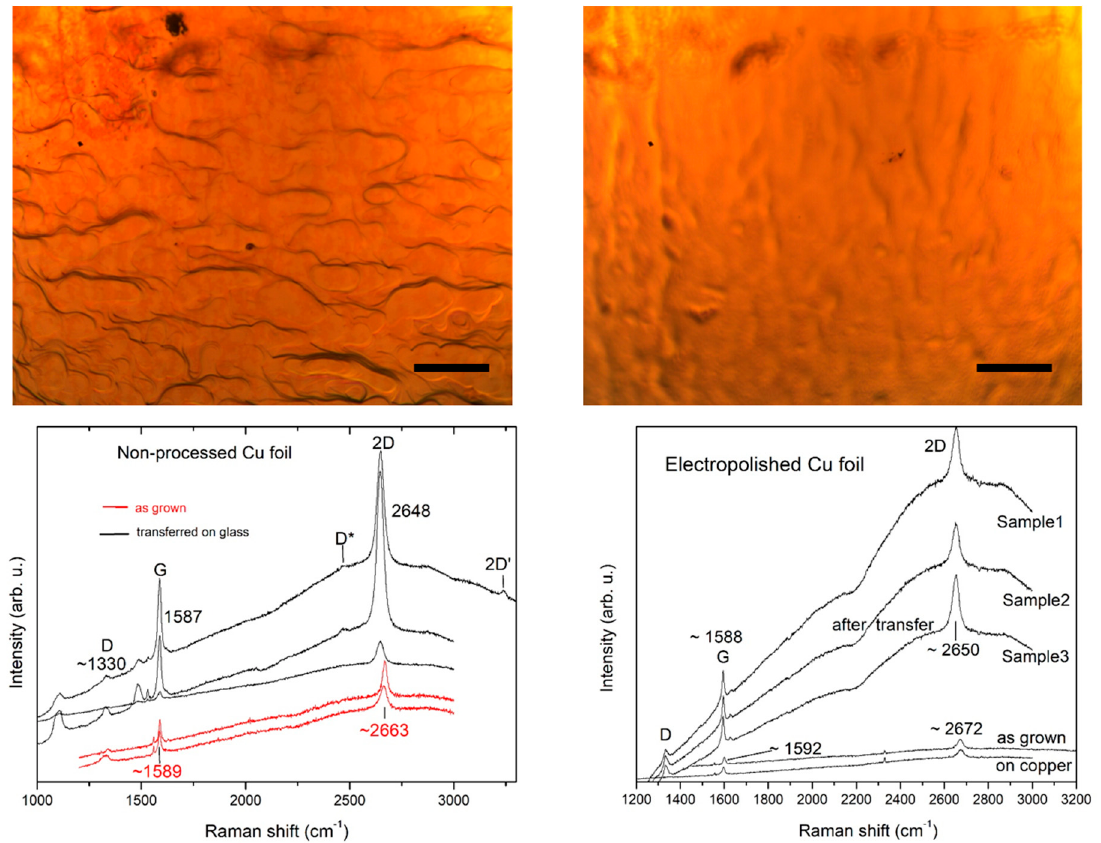
Figure 7. Top panel: Microscopic images of a nonprocessed ( left ) and an electropolished ( right ) Cu foil with graphene taken 1 week after the CVD growth. The scale bars represent 50 µ m. Bottom panel: corresponding Raman spectra from the graphene coatings on the Cu foils shown in the top panel taken before and after transfer on glass substrates.